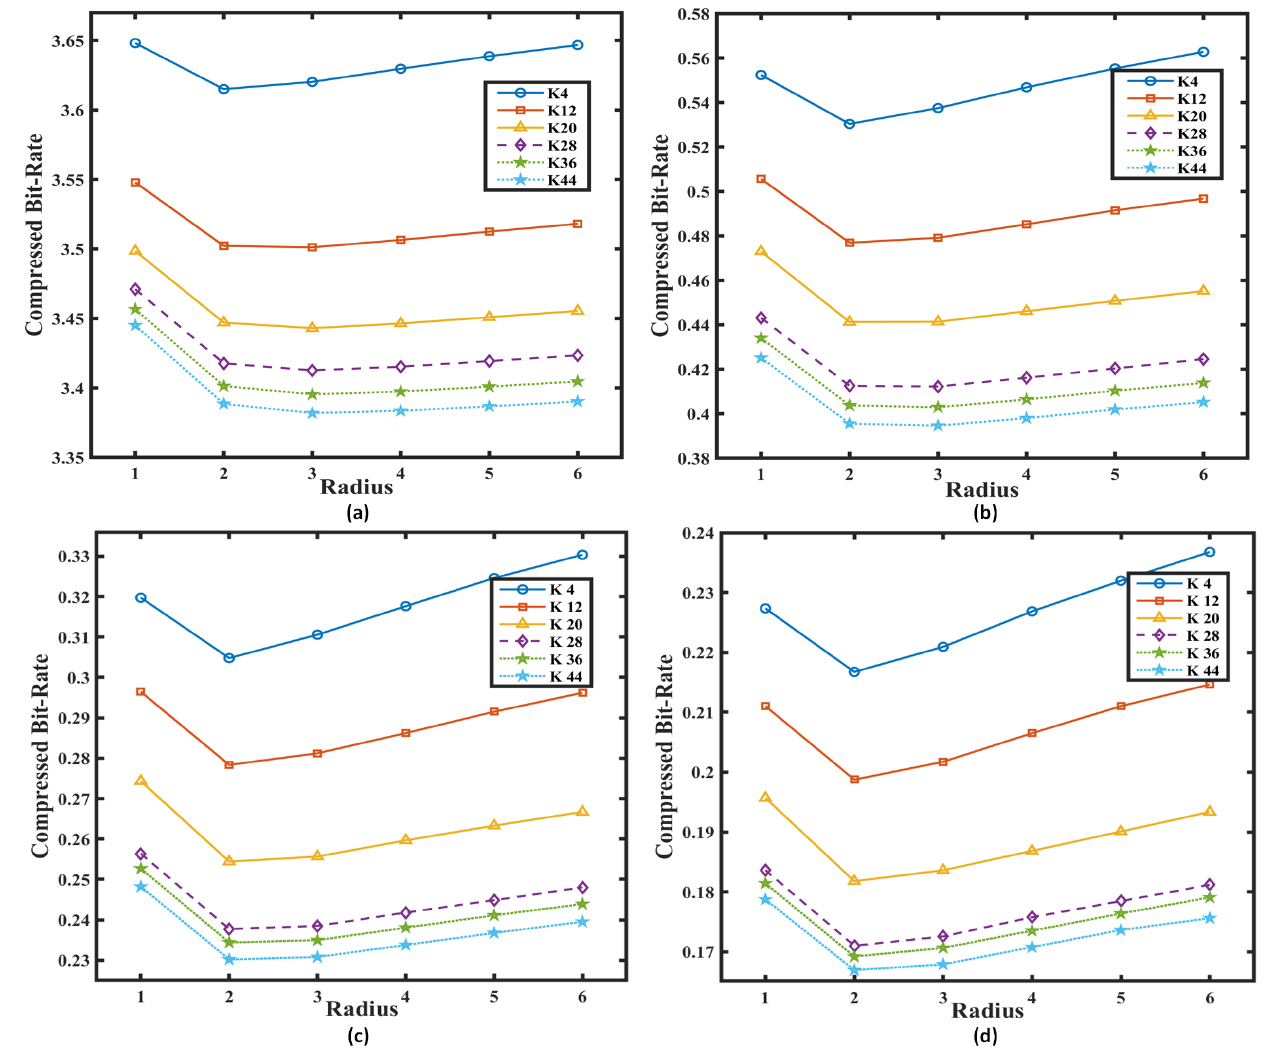
Figure 3. Average compressed bit-rate for different peak absolute errors: ( a ) encoded at Λ = 0, ( b ) encoded at Λ = 10, ( c ) encoded at Λ = 20, ( d ) encoded at Λ =